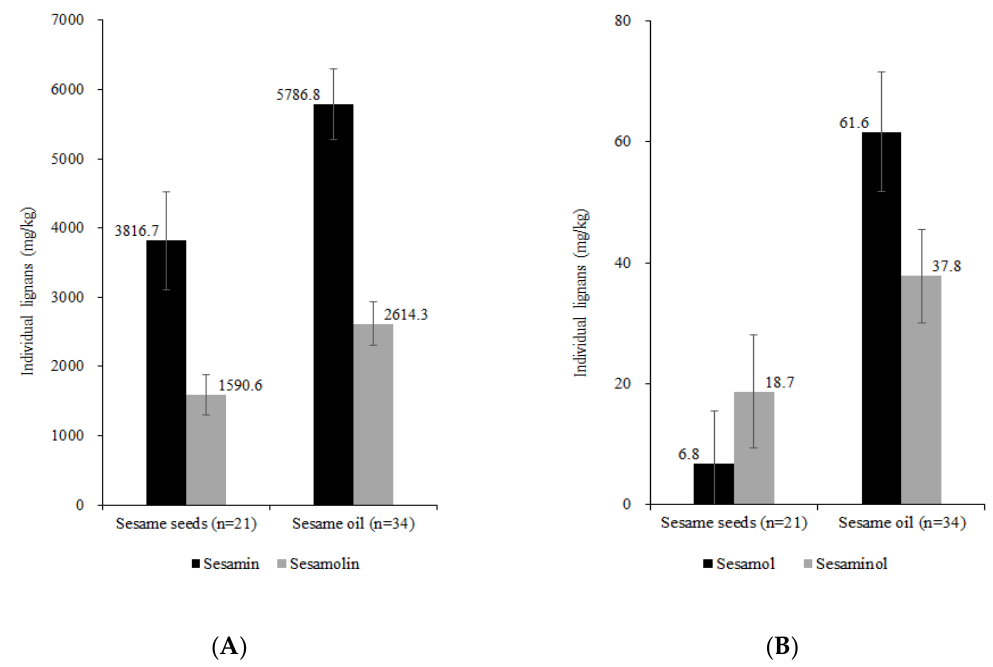
Figure 1. Individual lignan contents in sesame seeds ( n = 21) and sesame oil ( n = 34). ( A ) Sesamin and sesamolin; ( B ) Sesamol and sesaminol.